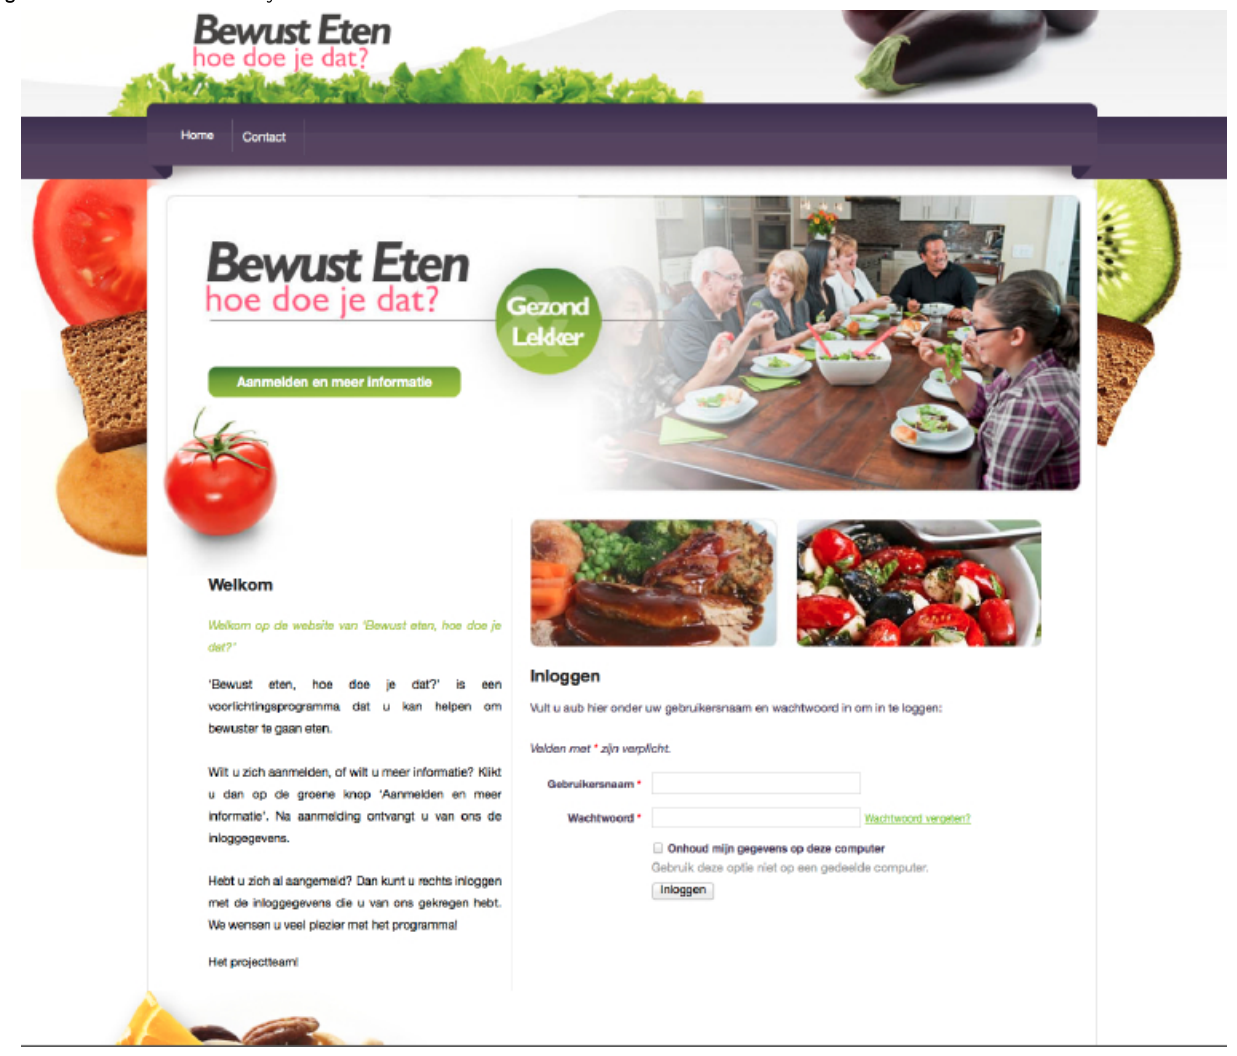
Figure 1. Screenshot of the study